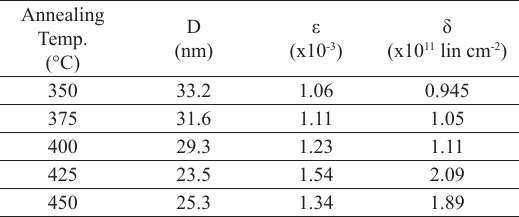
Table 1. Crystallite size, stress, and dislocation density of the ATO thin films annealed at different temperatures in the air atmosphere. Annealing